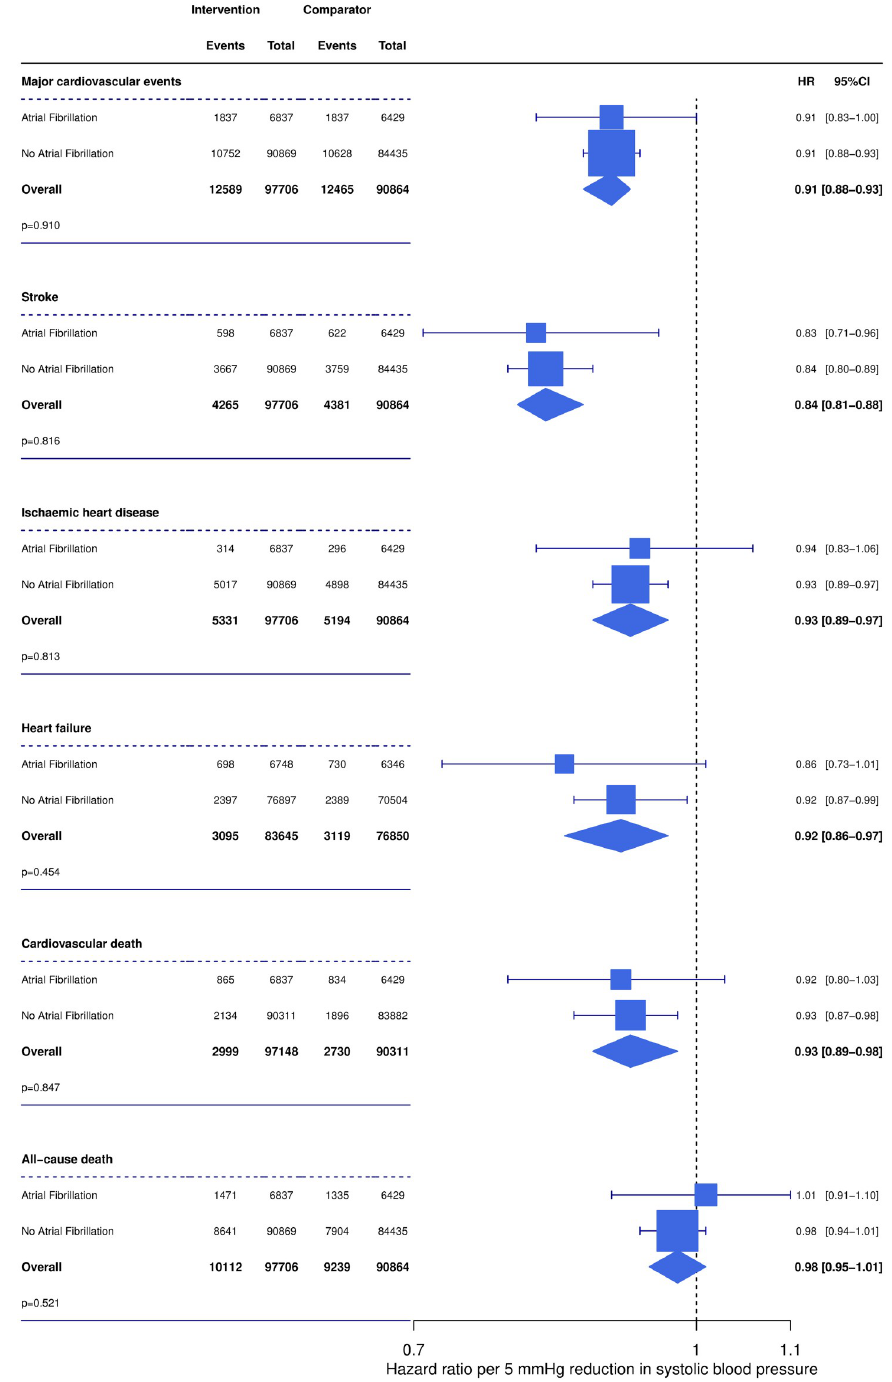
Fig 4. Effect of blood pressure lowering treatment on primary and secondary outcomes, stratified by presence of atrial fibrillation at baseline. Forest plot displays the HRs and 95% CIs for each outcome adjusted for a 5-mm Hg systolic blood pressure reduction. Further details on adjustment provided in the Methods. P values for test of difference between subgroups. CI, confidence interval; HR, hazard ratio.